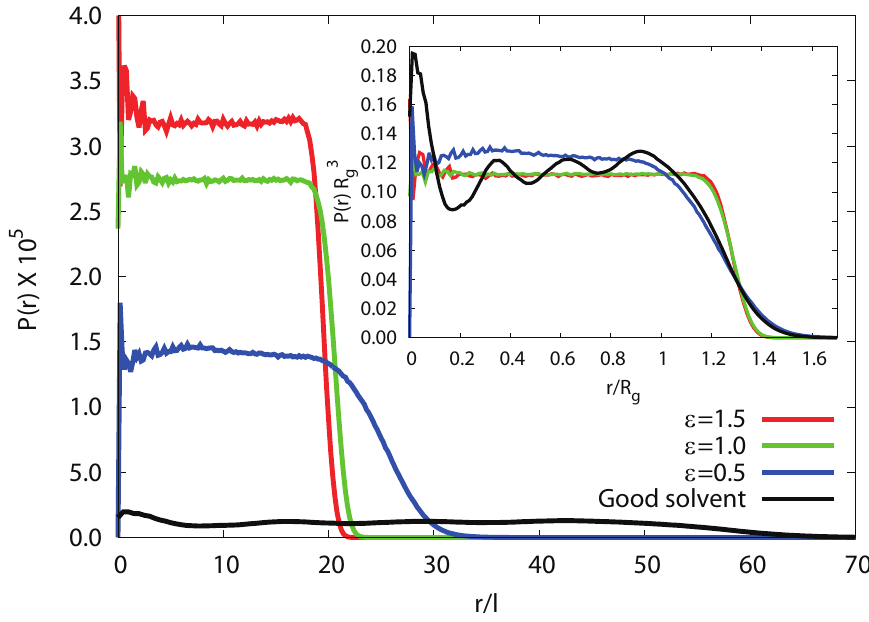
Figure 4. Radial monomer distribution functions P ( r ) for a microgel with N N = 729 under poor solvent conditions with (cid:15)/ ( k c (blue). In addition, P ( r ) for l Inset: the same distribution functions normalized by the respective radii of gyration, R the